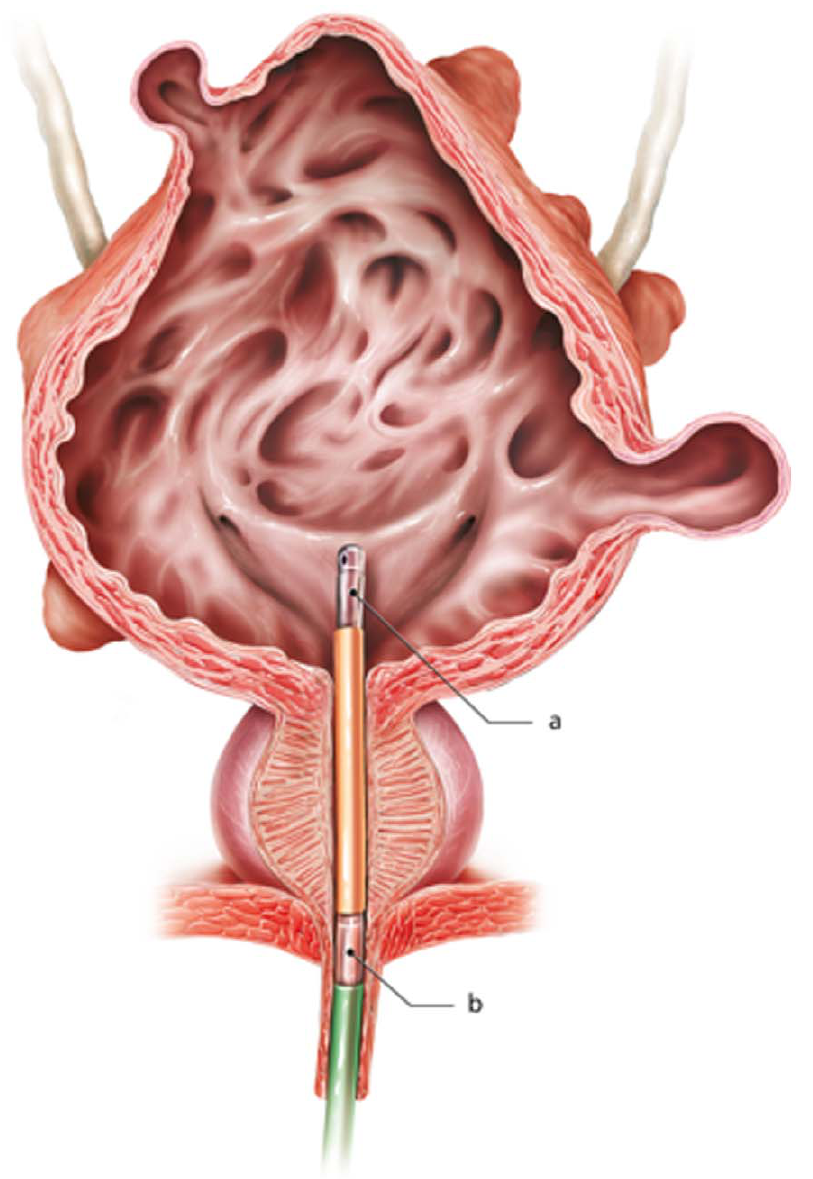
Figure 1. An 8 French transurethral reusable microtip dual sensor microtransducer catheter (Unisensor AG, Attikon, Switzerland) was used to simultaneously measure the intravesical and urethral pressure. The microtransducers were positioned in the bladder (a) and the external urethral sphincter (b) under the guidance of continuous pressure monitoring and fluoroscopy ensuring correct position during the urodynamic investigation.